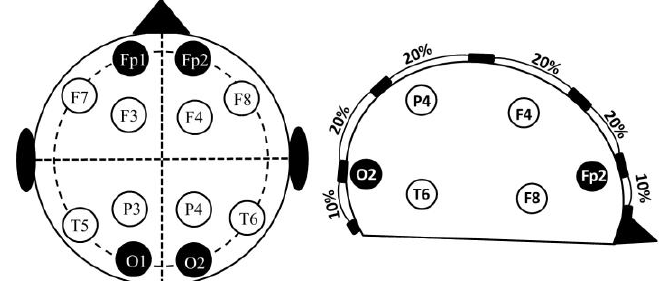
Figure 1. 10–20 electrode placements system for performing the Cerebral EBIS